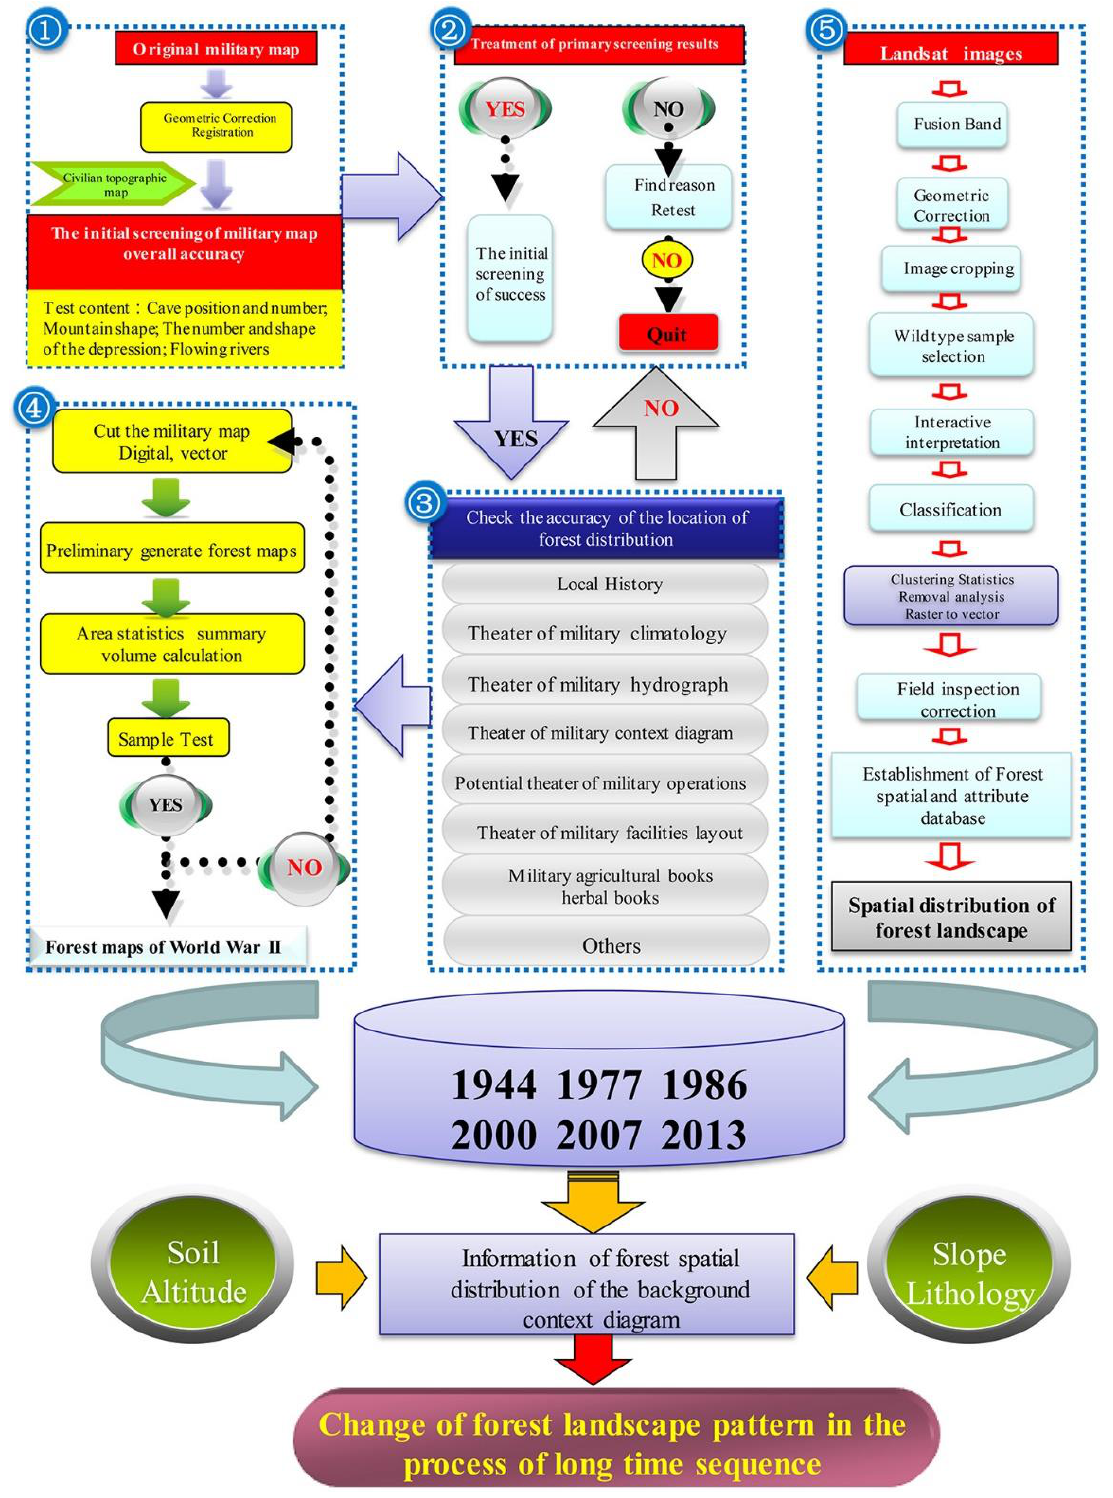
Figure 2. The technique flowchart showing the study of spatial patterns of forest landscape based on the military map and remote sensing images. (We constructed this figure using WPS office (https://platform.wps.cn/) (accessed on 29 November 2021))